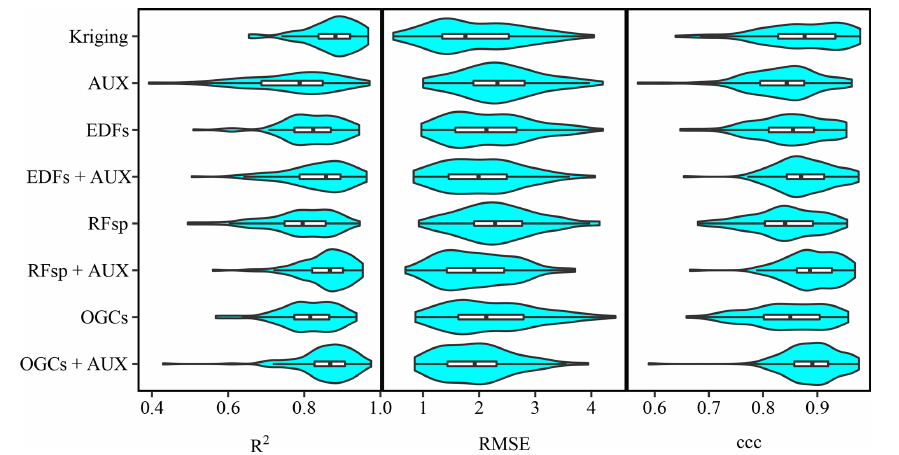
Figure 7. Violin plots showing accuracies of soil organic matter predictions on the Vindum dataset with kriging, and random forest models trained using either auxiliary data (AUX), Euclidean distance fields (EDFs), distances to observations (RFsp), oblique geographic coordinates (OGCs), or EDFs, RFsp, or OGCs in conjunction with AUX. The figure shows Pearson’s R 2 , root mean square error (RMSE) and Lin’s concordance obtained from 100 repeated splits (75% training dataset; 25% test dataset). Table 3. Ranked accuracies obtained with each method on the meuse dataset, calculated as Pearson’s R 2 , RMSE and ccc. Methods received shared ranks if a pairwise t test revealed no statistically significant difference between their accuracies for the metric in question. Each t test used accuracies obtained with 100 repeated splits into training and test datasets. AUX – auxiliary data; EDFs – Euclidean distance fields; RFsp – distances to observations; OGCs – oblique geographic coordinates; OK – ordinary kriging; and RK – regression